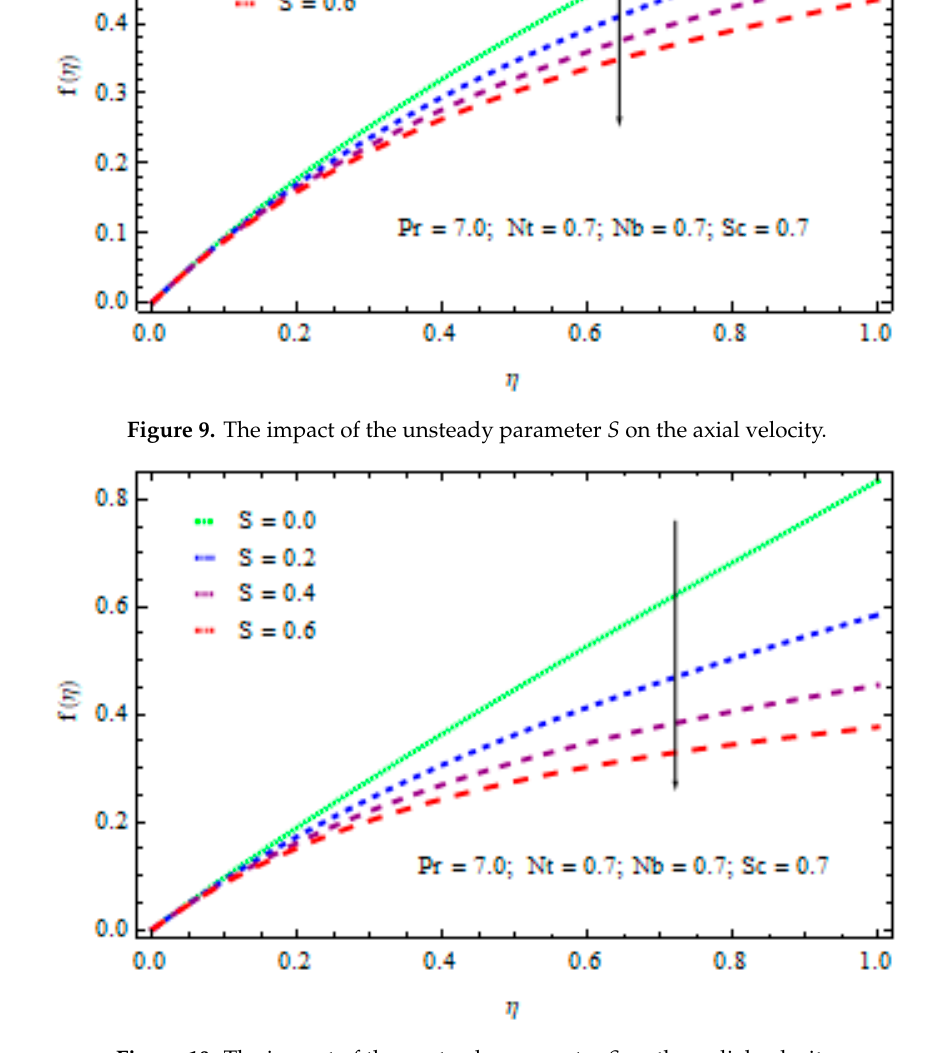
Figure 11. The impact of the unsteady parameter S on the draining flow in the x-direction.